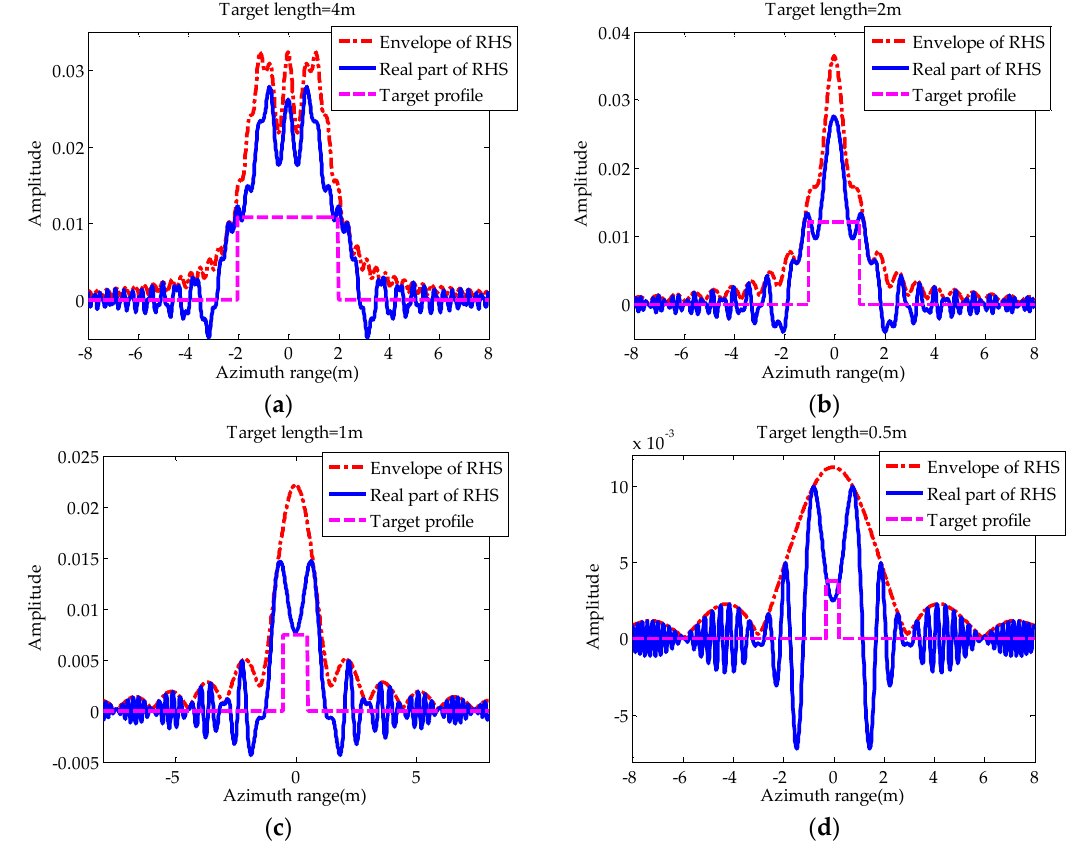
Figure 3. Radio holographic signals (RHSs) of targets with different lengths: ( a ) Target length = 4 m; ( b ) target length = 2 m; ( c ) target length = 1 m; ( d ) target length = 0.5 m. Table 1. Simulation parameters of rectangular